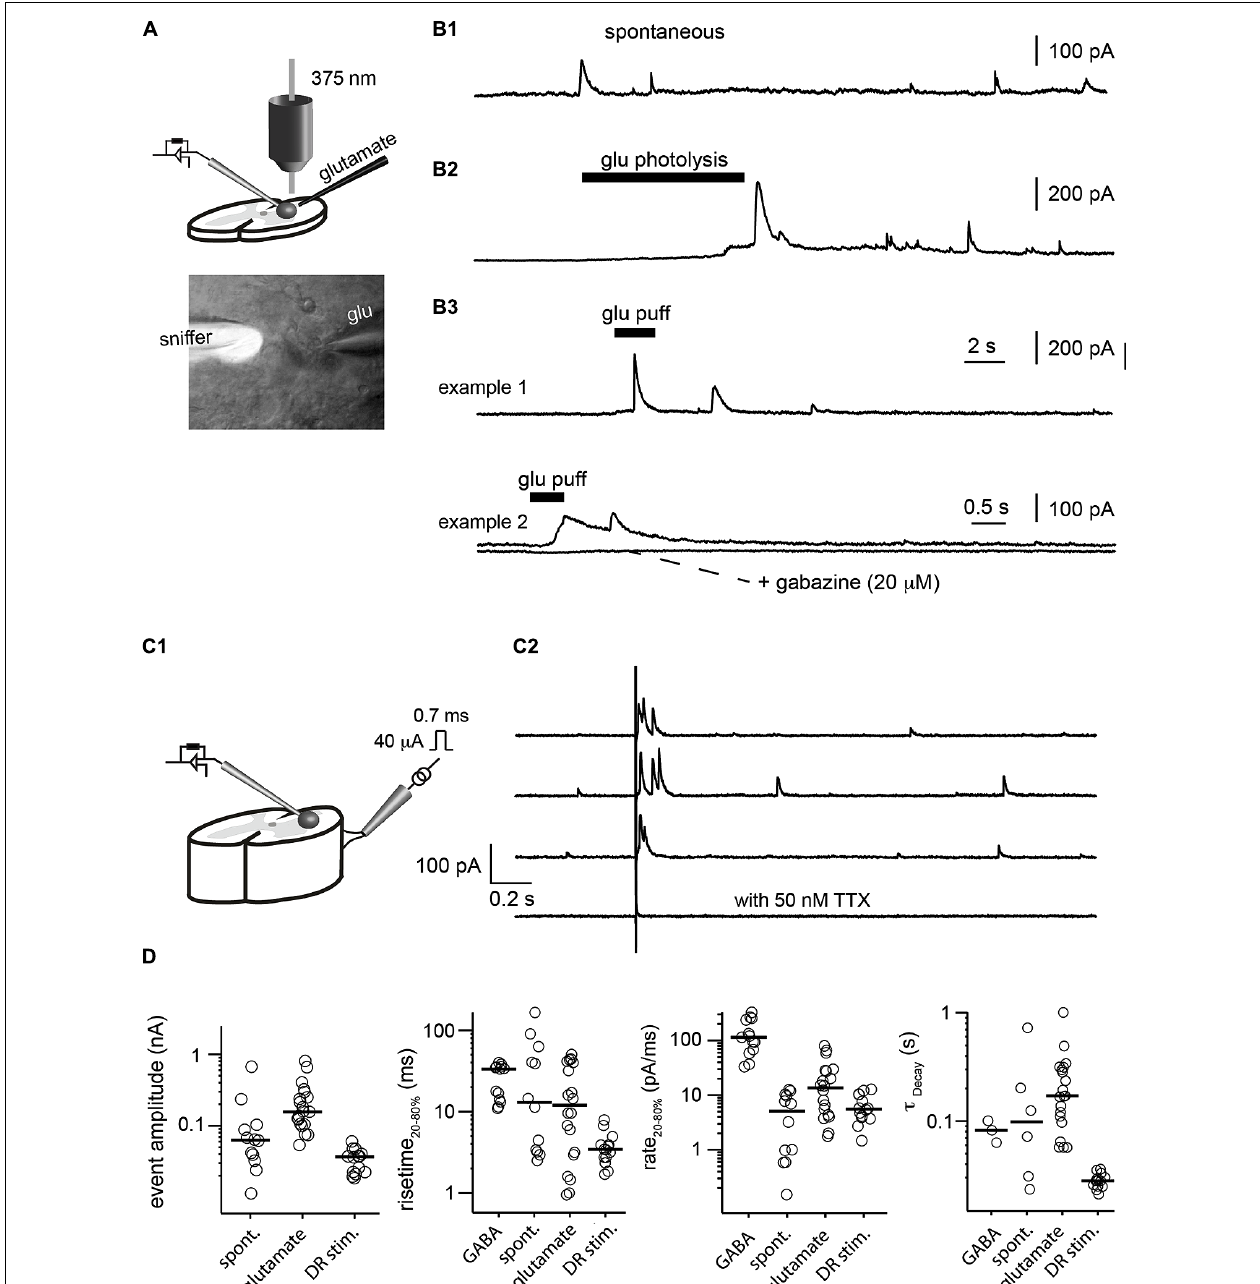
FIGURE 4 | Detection of GABA transients in a slice preparation. (A) Illustration of the experimental setup. GABA release was evoked either by puffing glutamate or uncaging glutamate with a 375 nm laser.The lower picture illustrates a sniffer filled with the fluorophore Alexa 488 (white) placed inside a slice from the spinal cord.The pipette coming from the right was used to puff glutamate (glu). (B) Examples of transient events recorded in the sniffer. (B1) Spontaneous events. (B2) Events evoked by glutamate uncaging. (B3) Events evoked by glutamate puff.The responses were abolished after addition of the GABA A receptor antagonist gabazine (20 μ M). (C1) Scheme of the preparation. Slice from the spinal cord with a dorsal root filament